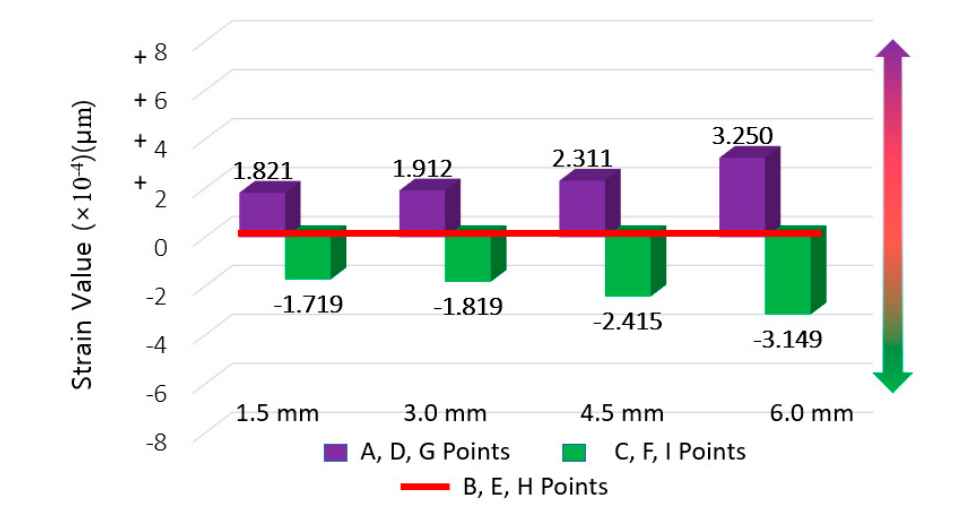
Figure 10. PUC strain difference results (for deriving strain concentration ratio).